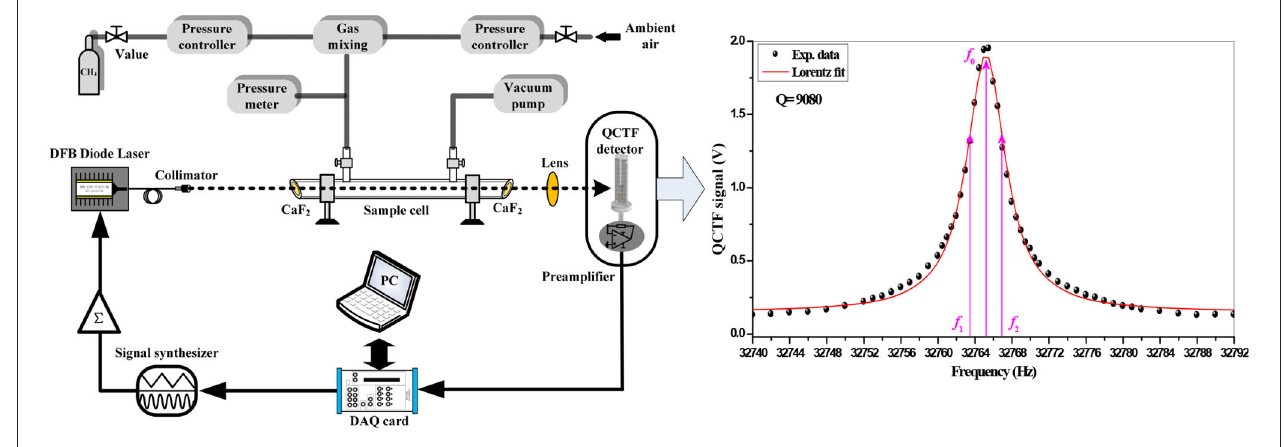
FIGURE 2 | Schematic configuration of the CH 4 sensor system.